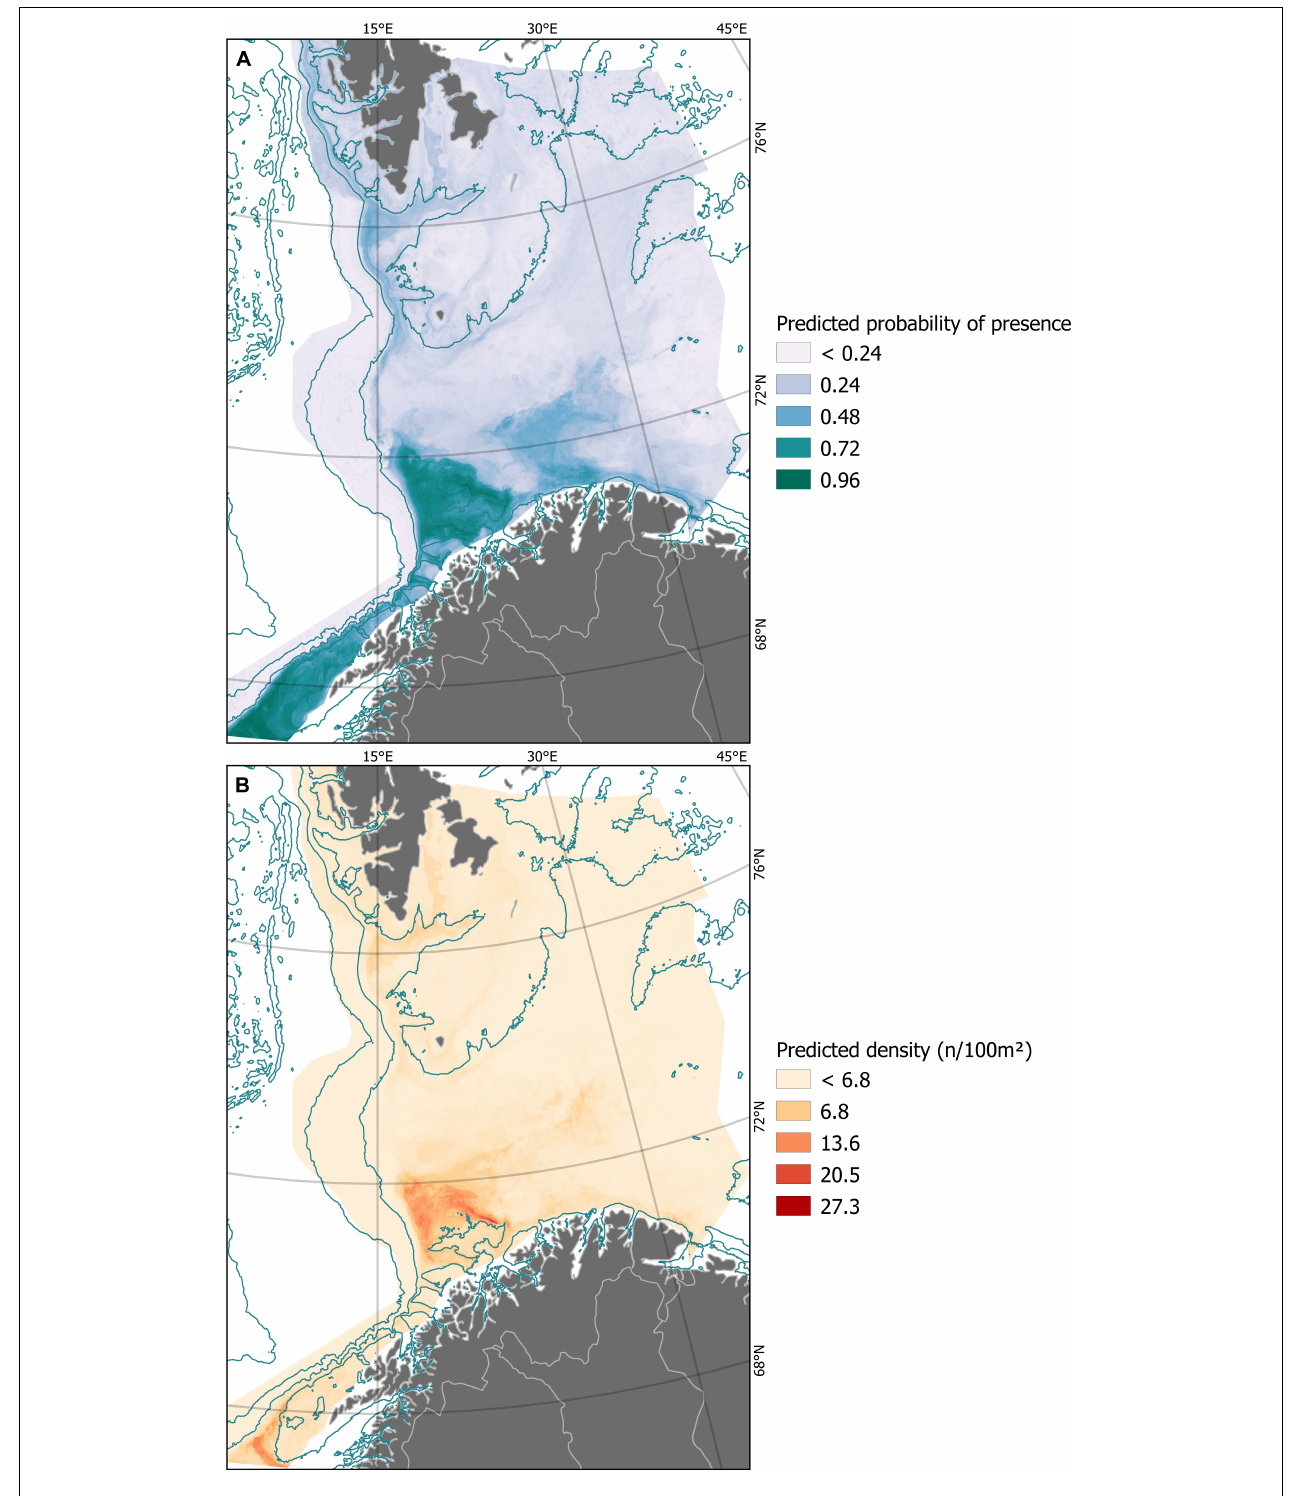
FIGURE 2 | Model predictions of probability of presence (A) and density (B) of soft-bottom, deep-sea sponges across the Norwegian Barents Sea as modeled using conditional inference forests and multiple environmental predictors. Also shown are selected bathymetric contour lines (dark blue) and land masses with political boundaries (gray), about which more details can be found in Figure 1 . For scale, refer also to Figure 1 .